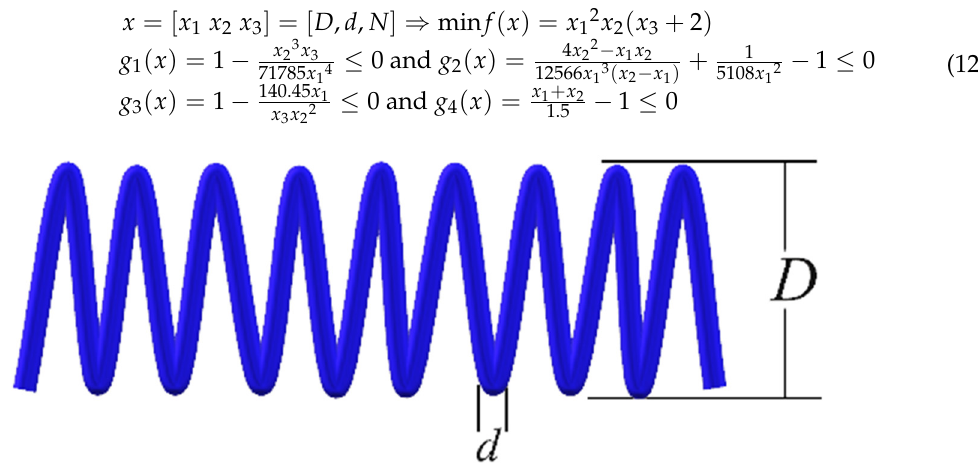
Figure 8. Tension coil spring. Table 14. Optimal design of tension coil spring.